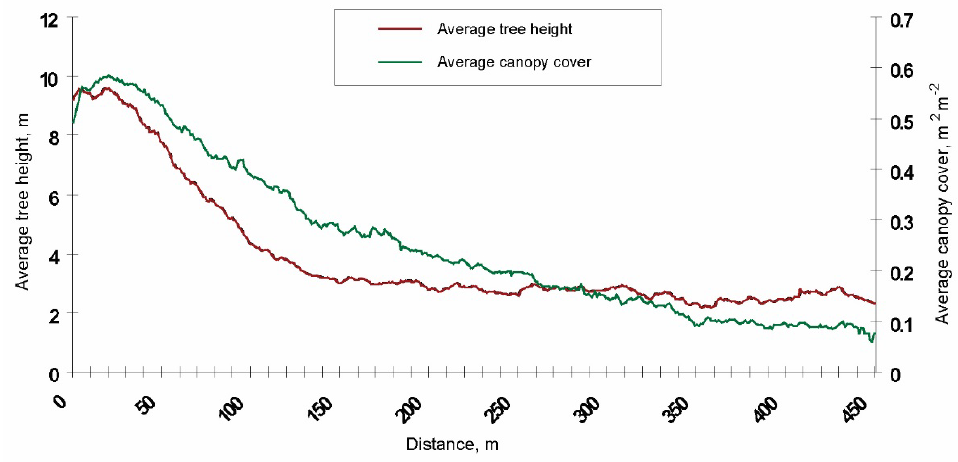
Figure 12. Relationships between the tree layer canopy cover (derived from LIDAR data) and average tree height, and distance from the cutoff ditch.